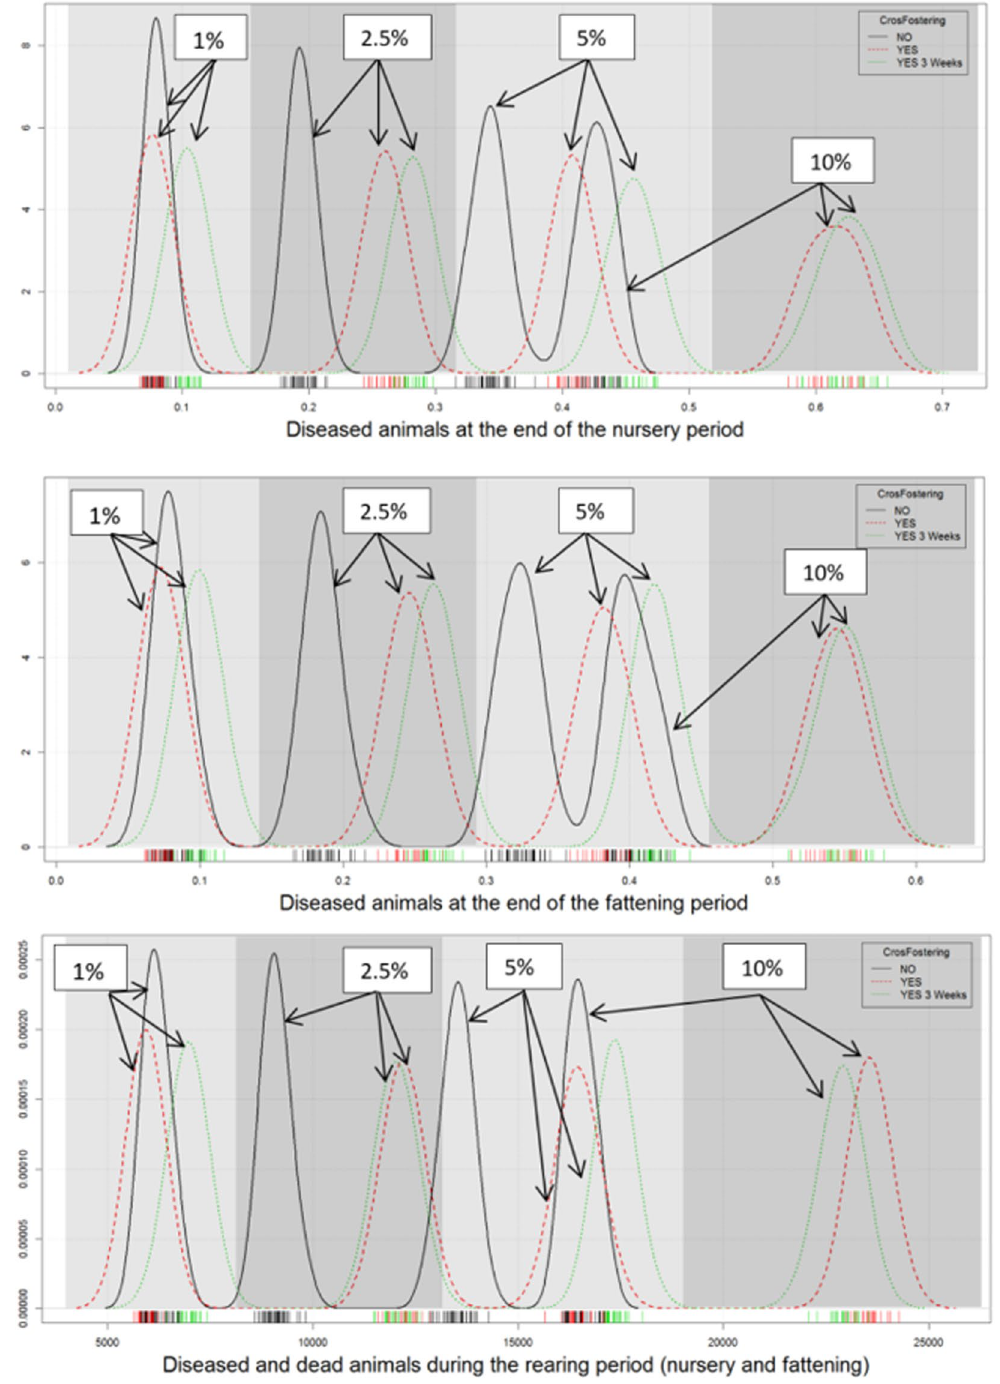
Figure 1. Density function of the infected animals at the end of the nursery and fattening period. Moreover, it is also represented the infected and dead animals during the whole rearing